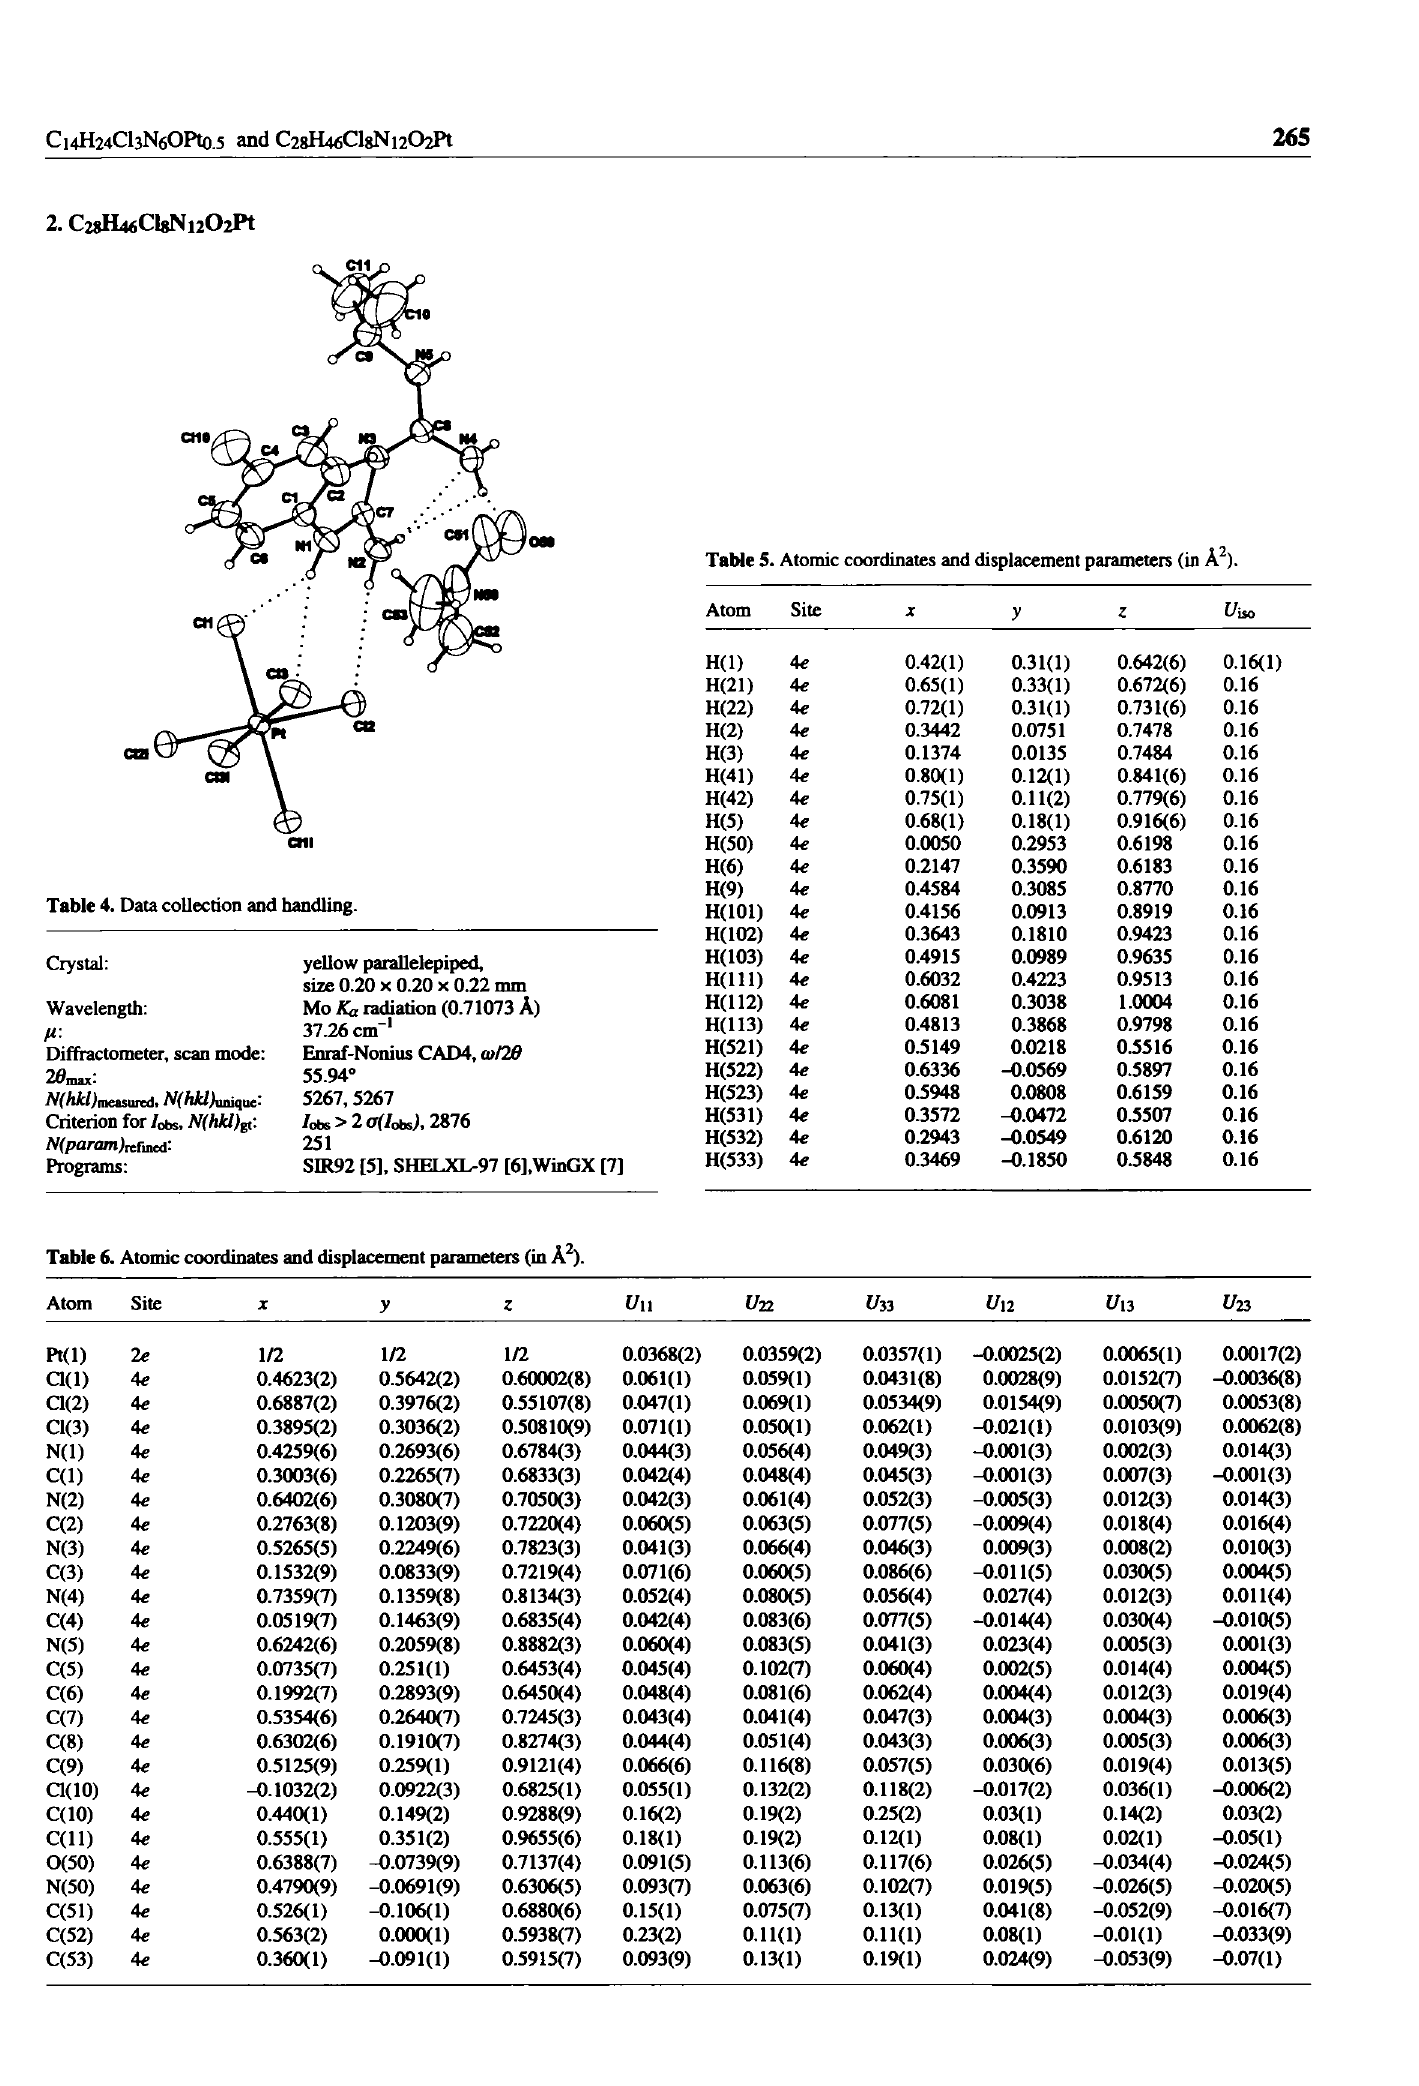
Table 5. Atomic coordinates and displacement parameters (in A 2 ).